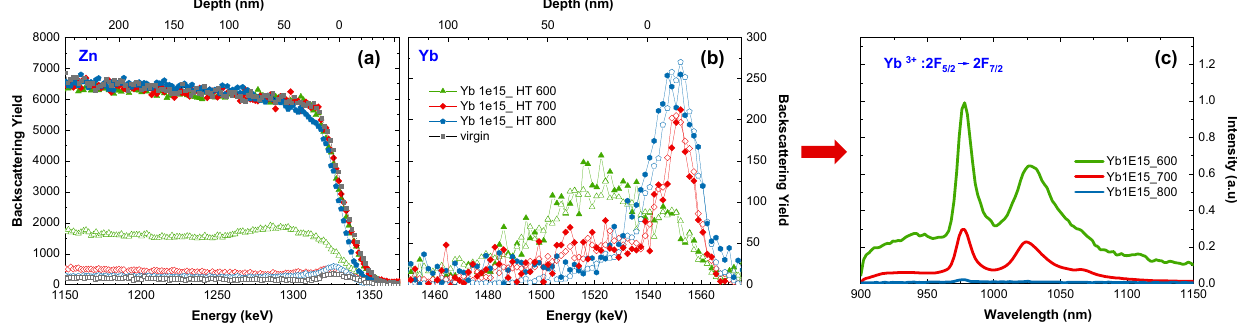
Figure 3. Random (solid symbols) and aligned (open symbols) RBS spectra ( a , b ) obtained for ZnO 267 implanted at different temperatures with 150keV Yb ions at the fluence of 1 × 10 15 /cm 2 . The 268 corresponding PL spectra ( c ). 269 Table 1. Numerical evaluation of the RBS and PL spectra of ZnO implanted at different high 270 temperatures with 150 keV Yb ions at the fluence of 1 × 10 15 /cm 2 . 271 253 RBS PL The backscattering yield of Intensity (%) Yb ions on the surface (counts) (a.u.) 257 1.00 0.30 3.5 248 0.03 272 273 274 265 275 276